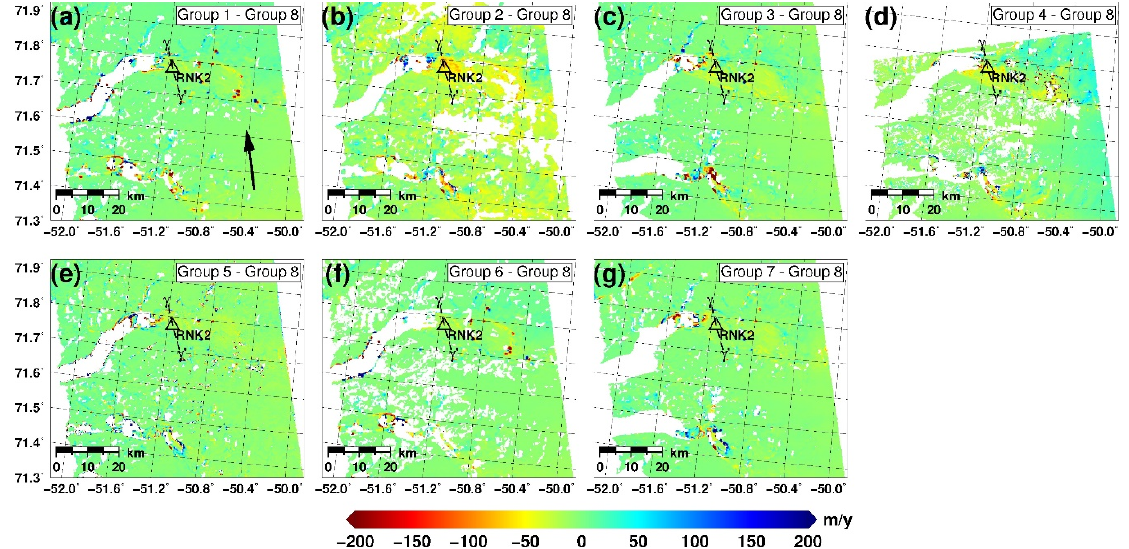
Figure 22. Task 4 azimuth velocity differences between groups 1 to 7 ( a – g ) and group 8 in the area of RNK2 GPS station. The dashed line represents the trace of the profiles in Figure 24f.